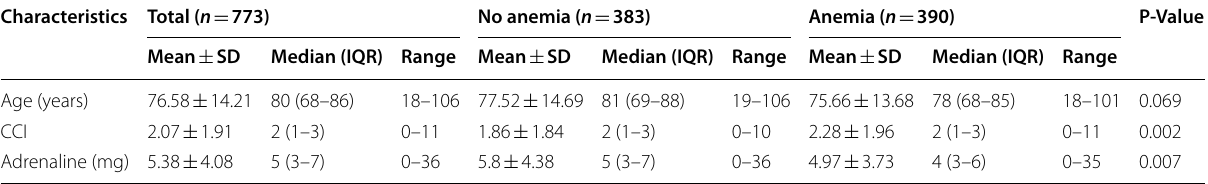
Table 2 Patients’ characteristics. Anemia was defined based on the lowest hemoglobin in the 48 h preceding the arrest — continuous variables